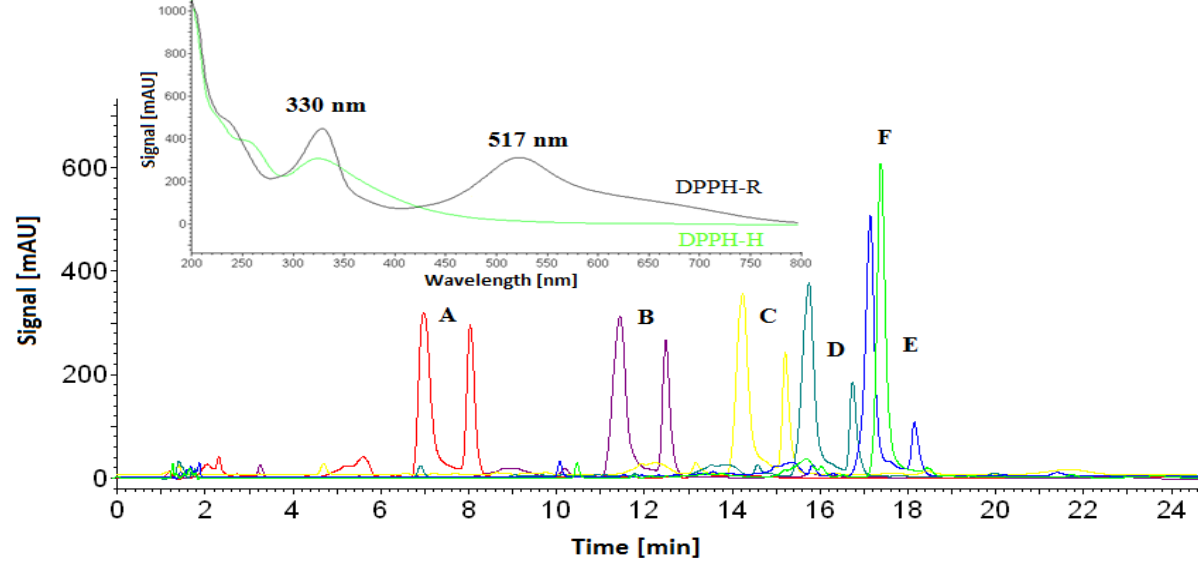
Figure 1. Overlaid chromatograms of 1 mM DPPH obtained by isocratic elution with 60% ACN/water (A, red) and gradient elution starting from 5%ACN (F, green), 20%ACN (E, blue), 30%ACN (D, light blue), 40% ACN (C, yellow), and 50% ACN (B, violet) and ending with 60% ACN within 20 min (detection, λ = 330 nm). Inserts show spectra of both forms recorded in the range of 200–800 nm by the DAD detector.